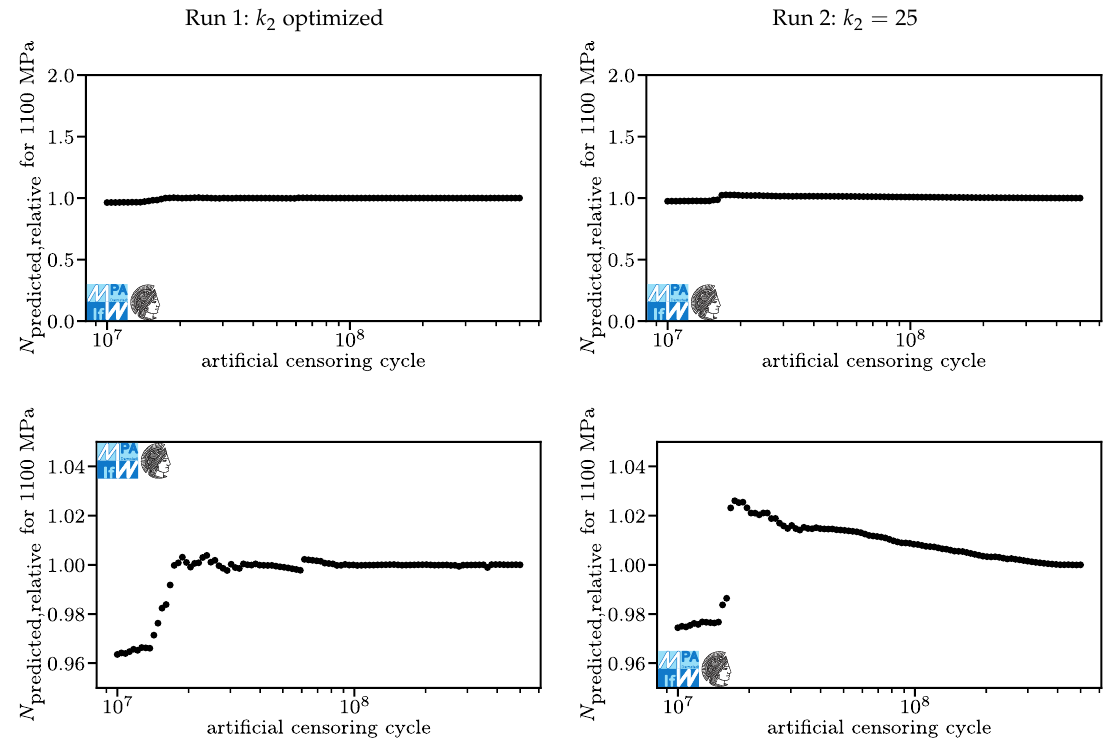
Figure 8. Lifetime predictions for Run 1 ( left ) and Run 2 ( right ), overview and detail for stroke stresses of 1100 MPa.